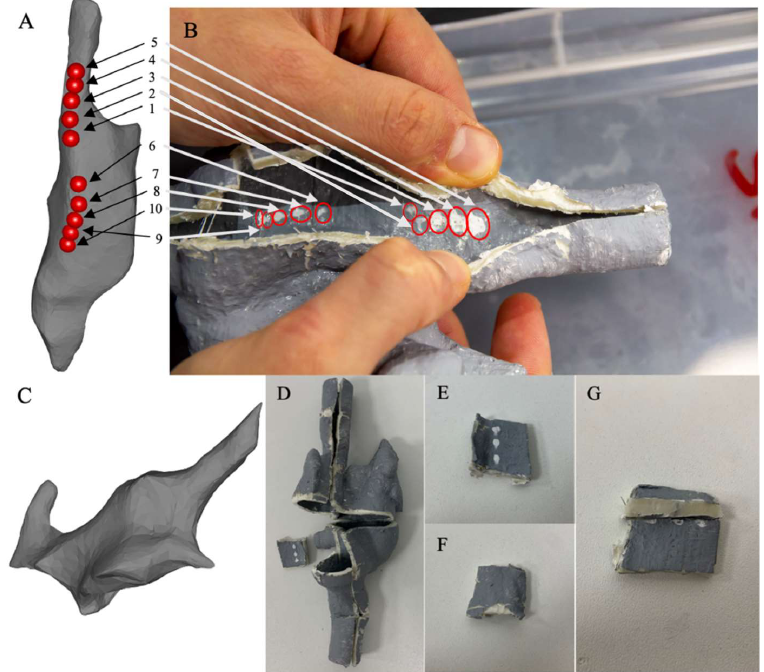
Figure 10. CARTO3 mapping and ablation. ( A ) Exported geometry and ablation points (numbered 1 to 10) from the CARTO3 system showing the RA and the venae cavae. ( B ) Cut-away of the heart model immediately after the ablation experiment showing the lesions and their correspondence to the ablation points. ( C ) Partial CARTO3 map of the LA. ( D ) Cut-away of the dry heart model. ( E ) Ablation points clearly visible on the internal surface. ( F ) External surface is not affected by the RFA. ( G ) Transmural cut that shows no effect inside the model wall.